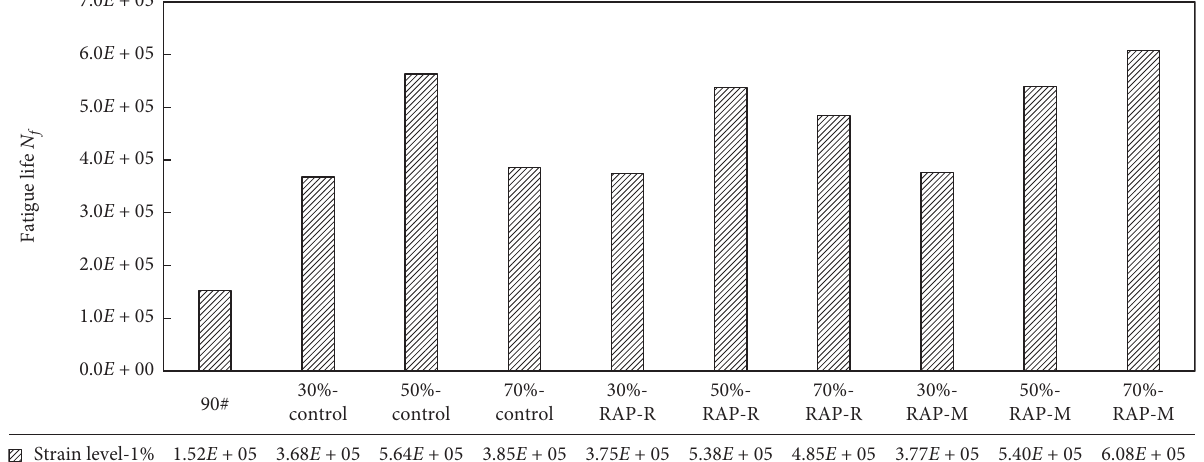
Figure 28: N f at applied strain level of 1% for various asphalt